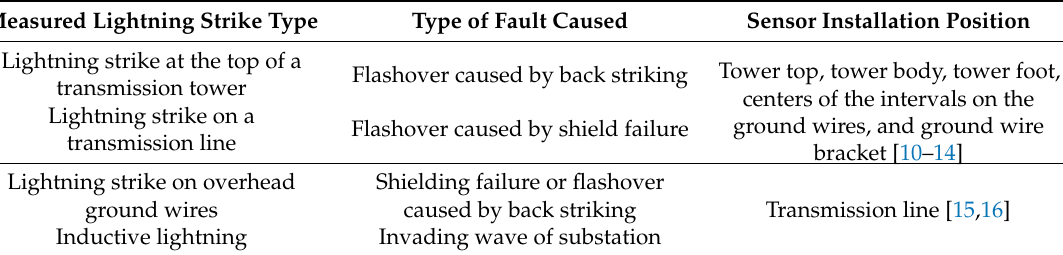
Table 1. Comparison of di ff erent measurement